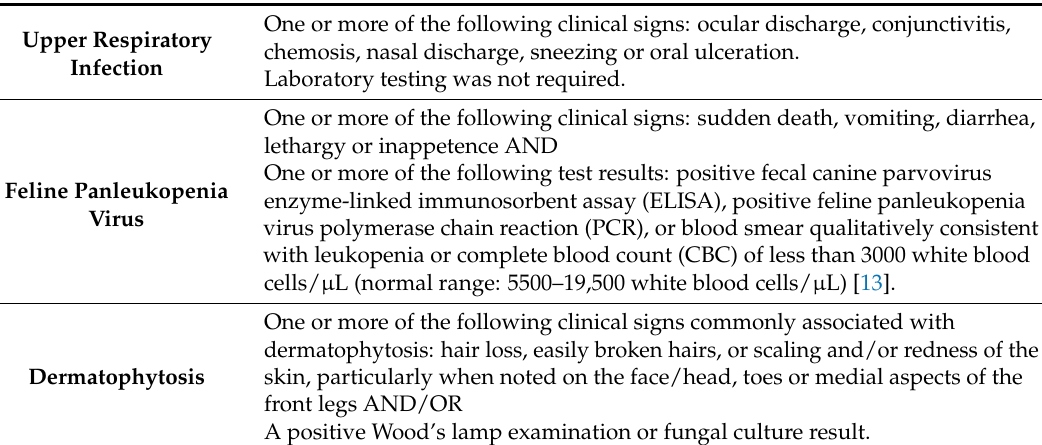
Table 1. Case definitions for URI, FPV and